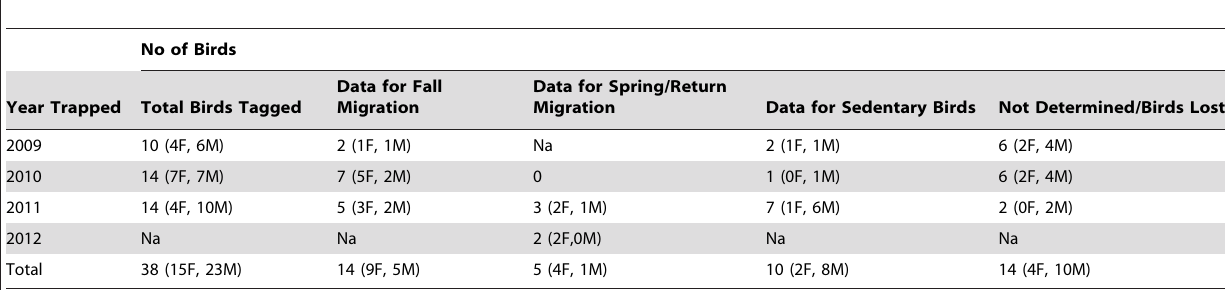
Table 1. Number of individuals by year and sex classified as migrants and residents and birds for which data could not be obtained.